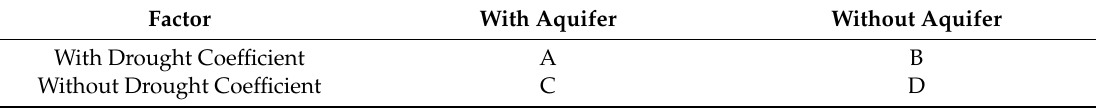
Table 2. Simulation scenarios for WEAP-Elqui-based outcome vulnerability. Factor With Aquifer